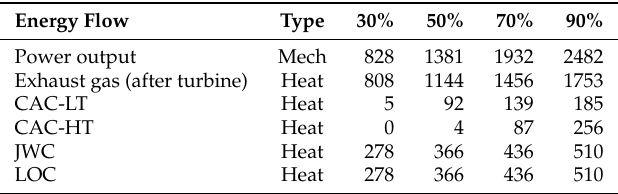
Table A4. Auxiliary engines, energy flows at different engine